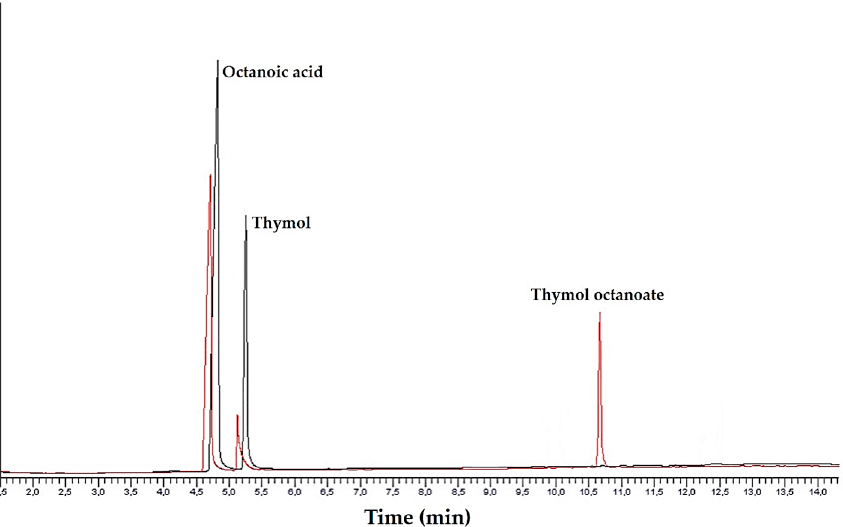
Figure 6. Overlapping of chromatograms corresponding to samples from the beginning and end of the esterification reaction of thymol and octanoic acid. Reaction conditions: 2 mmol of octanoic acid, 0.5 mmol of thymol, 200 µL of CALB solution, 50 °C, and 24 h of reaction. The black line corresponds to the sample at the beginning of the reaction, the red line corresponds to the sample at the end of the reaction.